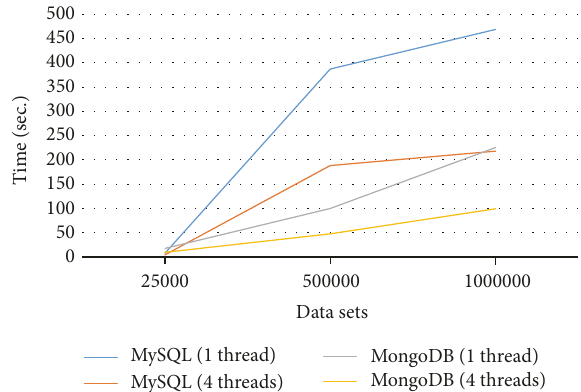
Figure 1: The graph of the dependence of the execution time on the number of records in the data set.